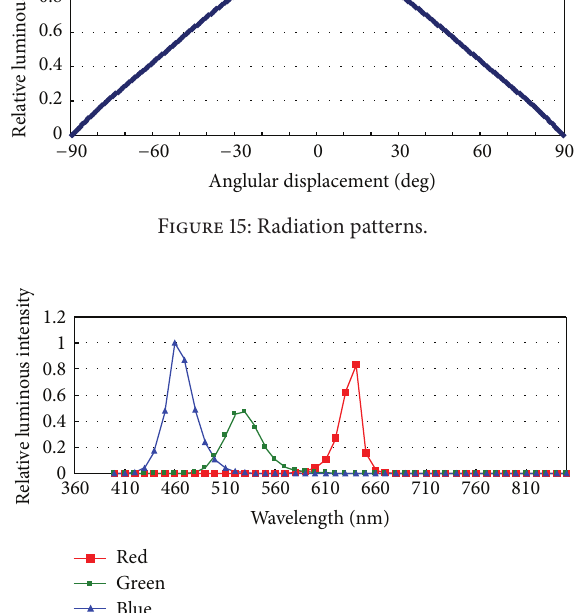
Figure 16: The luminous spectra of RGB